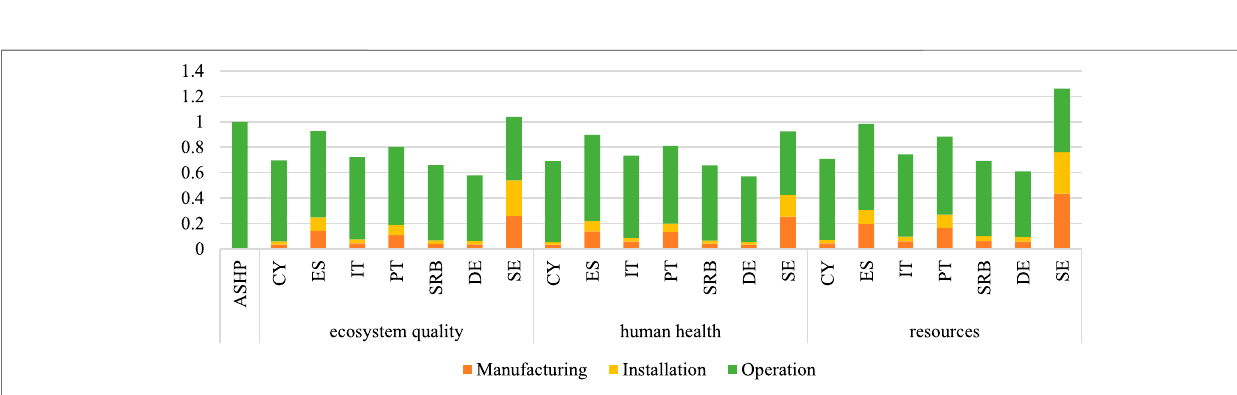
FIGURE 7 | Percentage ratio of the different types of GSHP systems to the ASHP per country, using ReCiPe end-point method for the ecosystem quality impact per FU.